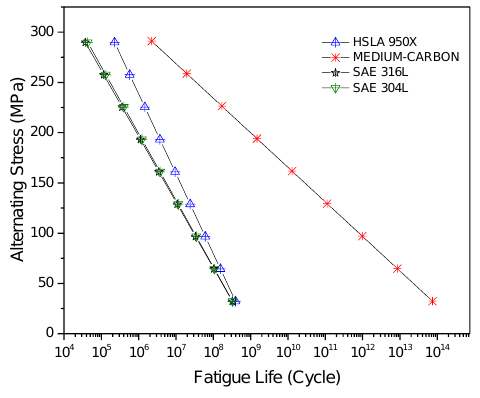
Figure 20. Relationship Between Alternating Stress and Fatigue Life for Each Material Used Figure 20: Relationship between alternating stress and fatigue life for each material